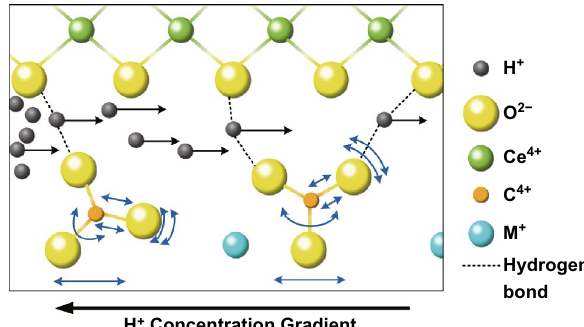
Fig. 7 Proposed “Swing Model” in samarium‑doped ceria (SDC)–